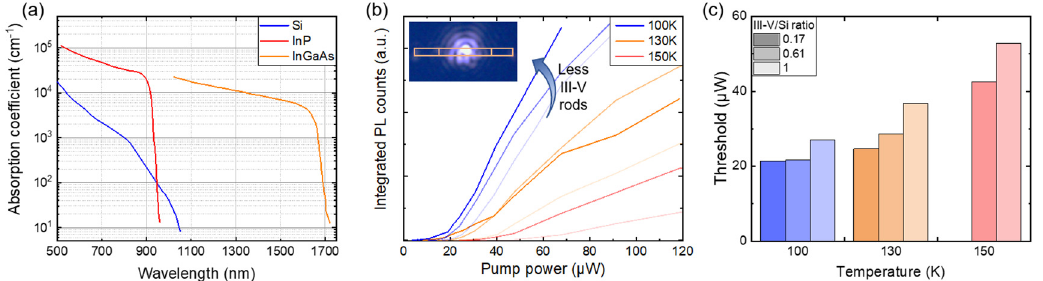
Figure 5. ( a ) Absorption coefficient of Si, InP, and InGaAs [44]. At 900 nm, the absorption coefficient of InP is two orders of magnitude larger than for Si. ( b ) Light in ‐ light out curves for hybrid InP/Si cavities measured at different temperatures (line color) and for different numbers of Si rods in the PhC mirror (color intensity). The inset shows the far ‐ field emission pattern above threshold. ( c ) Lasing threshold of typical devices with increasing ratio of III ‐ V/Si rods, where 0 corresponds to all Si and 1 to all InP; in all cases, the total number of rods is 41. The threshold increases with the temperature and III ‐ V/Si ratio.